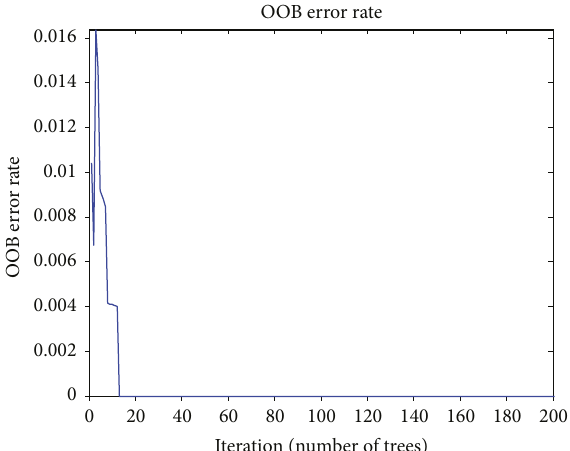
Figure 9: Diagnosis results of di ff erent fault categories.